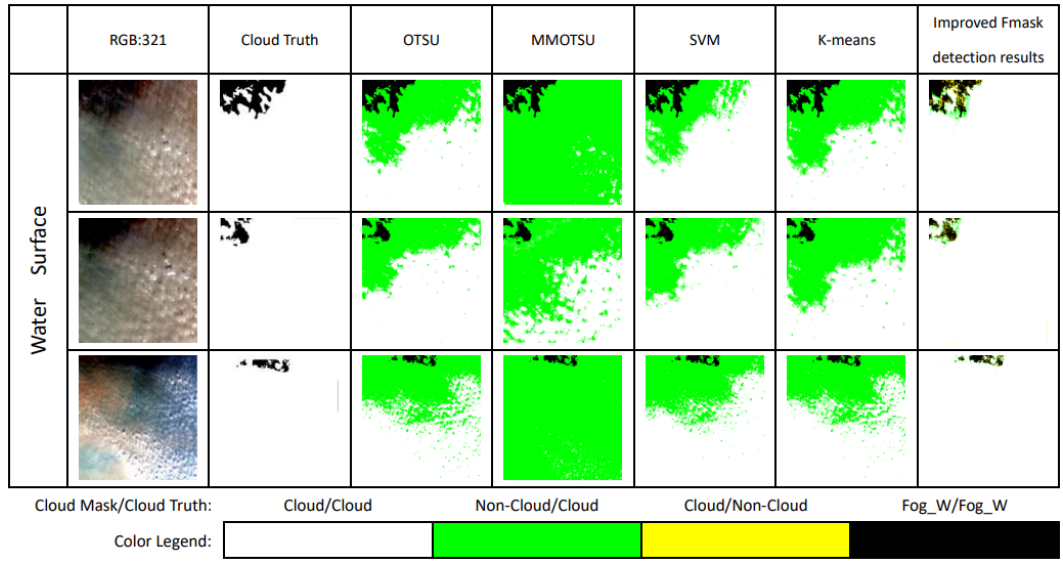
Figure 9. Comparison of detection results of different methods for high-humidity fog and stratus over water.